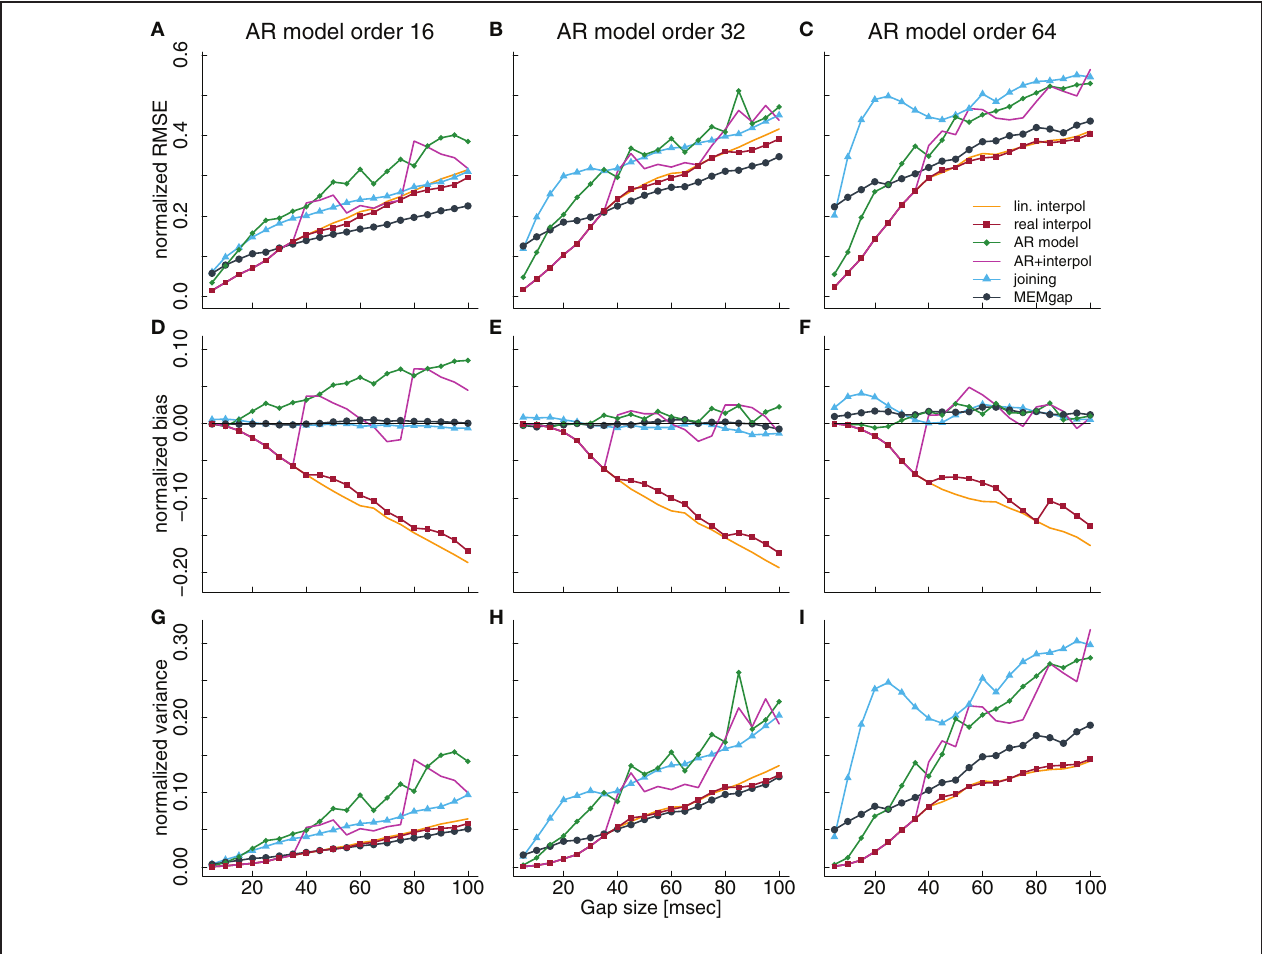
FIGURE 4 | Normalized RMSE, bias, and variance of the spectral power estimation for a model order of 16 (A,D,G), 32 (B,E,H), and 64 (C,F,I) for the frequency bin at 21Hz. The colored lines illustrate the course of the